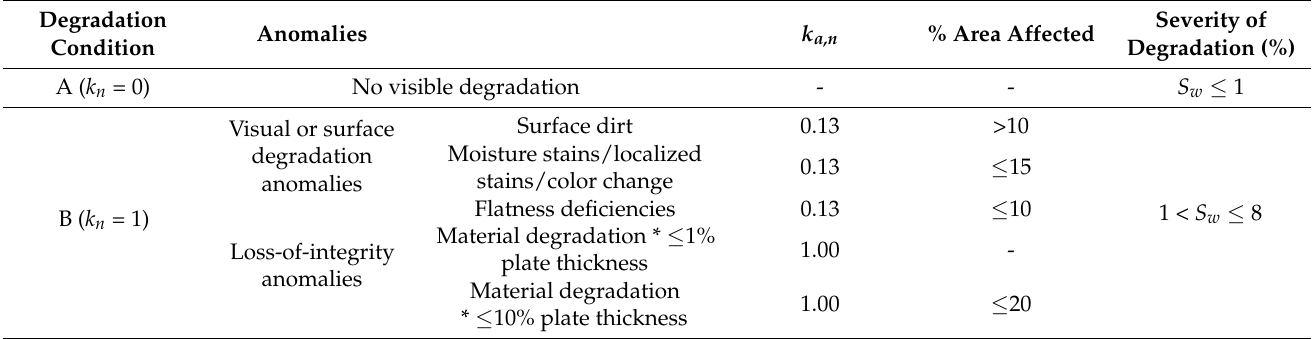
Table A2. Classification system for natural stone claddings (NSC)